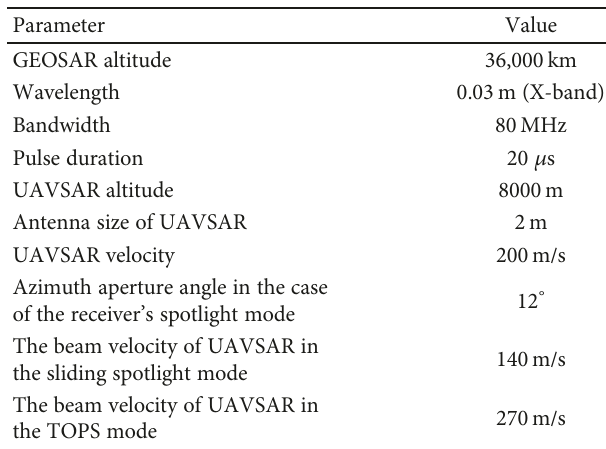
Figure 3: The composite scene with 9-point targets. Here, DX and DY represent the azimuth and the range resolution, respectively. Table 2: Simulation